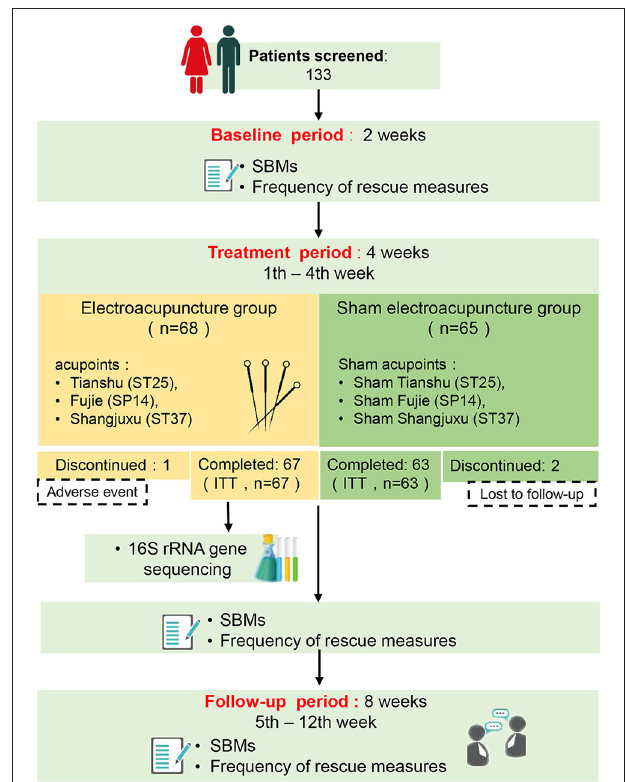
FIGURE 1 | Flow diagram of the study. SBM, spontaneous bowel movements; ITT, intent to